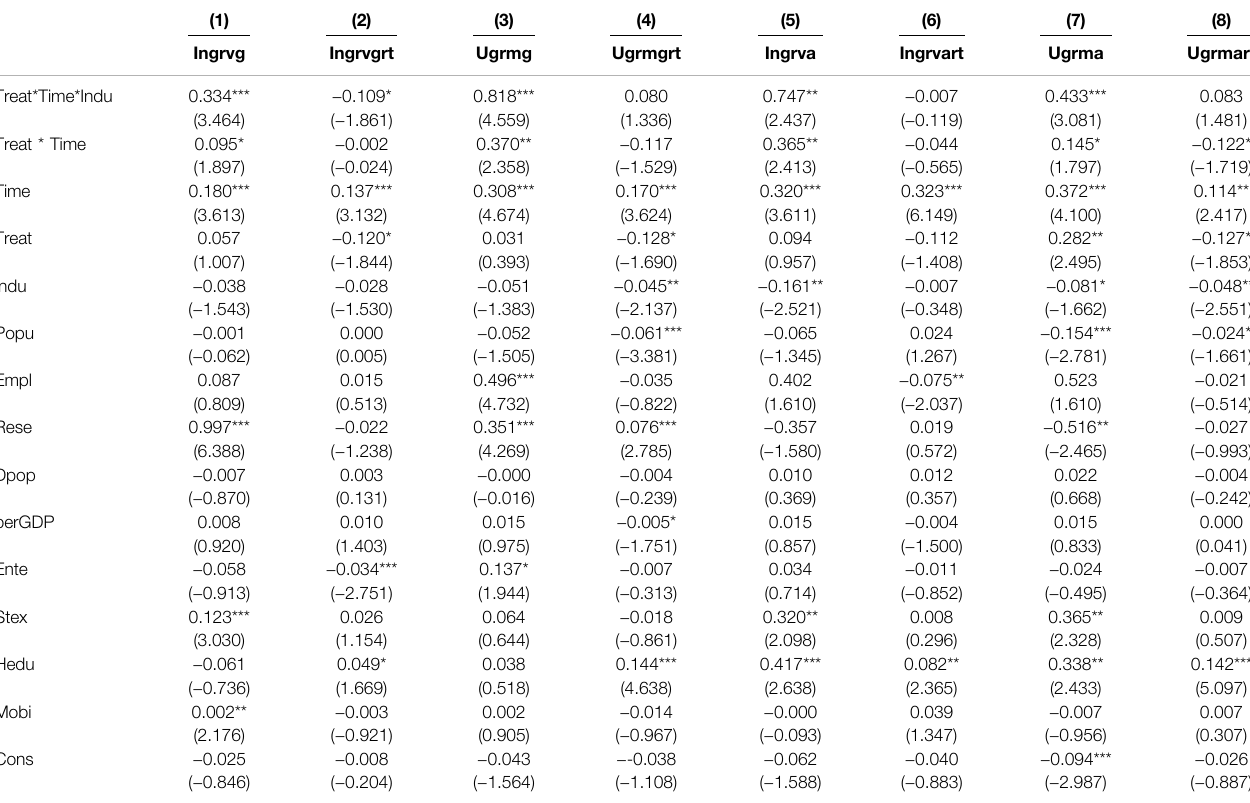
TABLE 8 | Moderating effect test